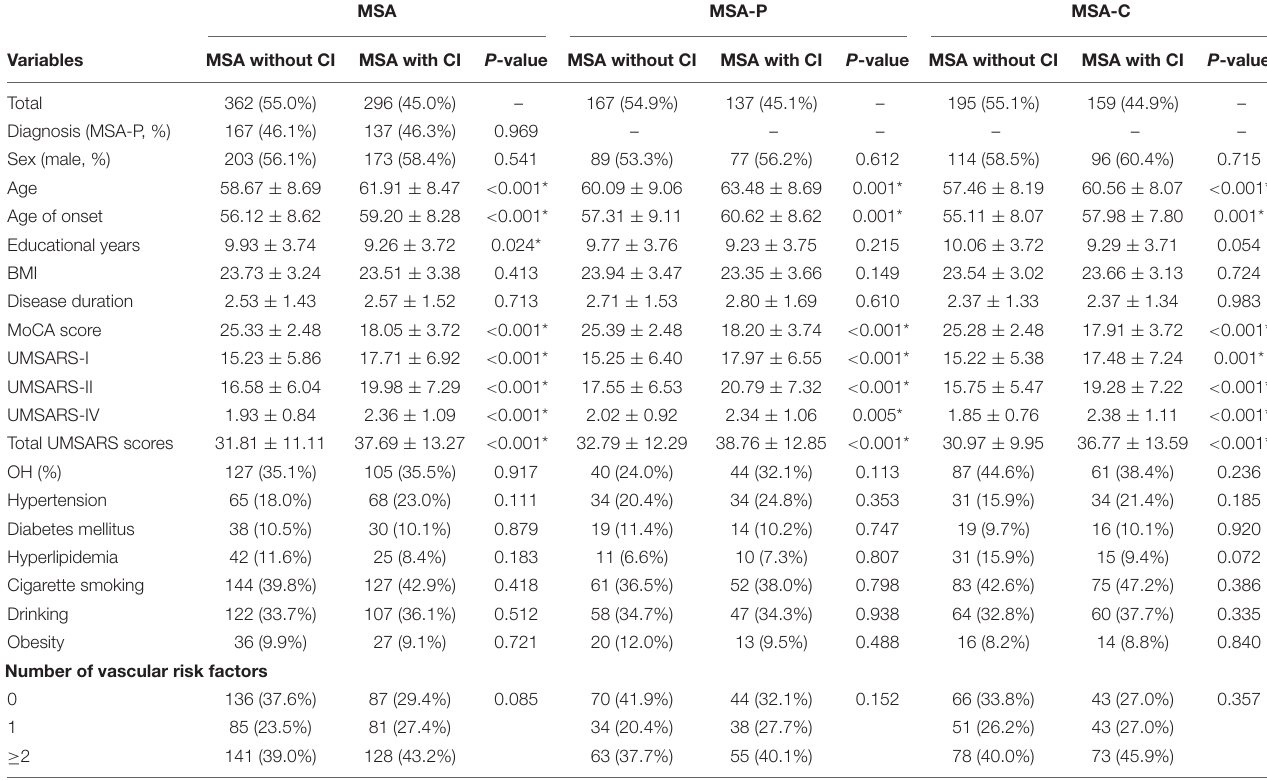
TABLE 2 | The comparison of the demographic and clinical features between patients with and without CI in the MSA, MSA-P, and MSA-C groups. MSA MSA-P MSA-C